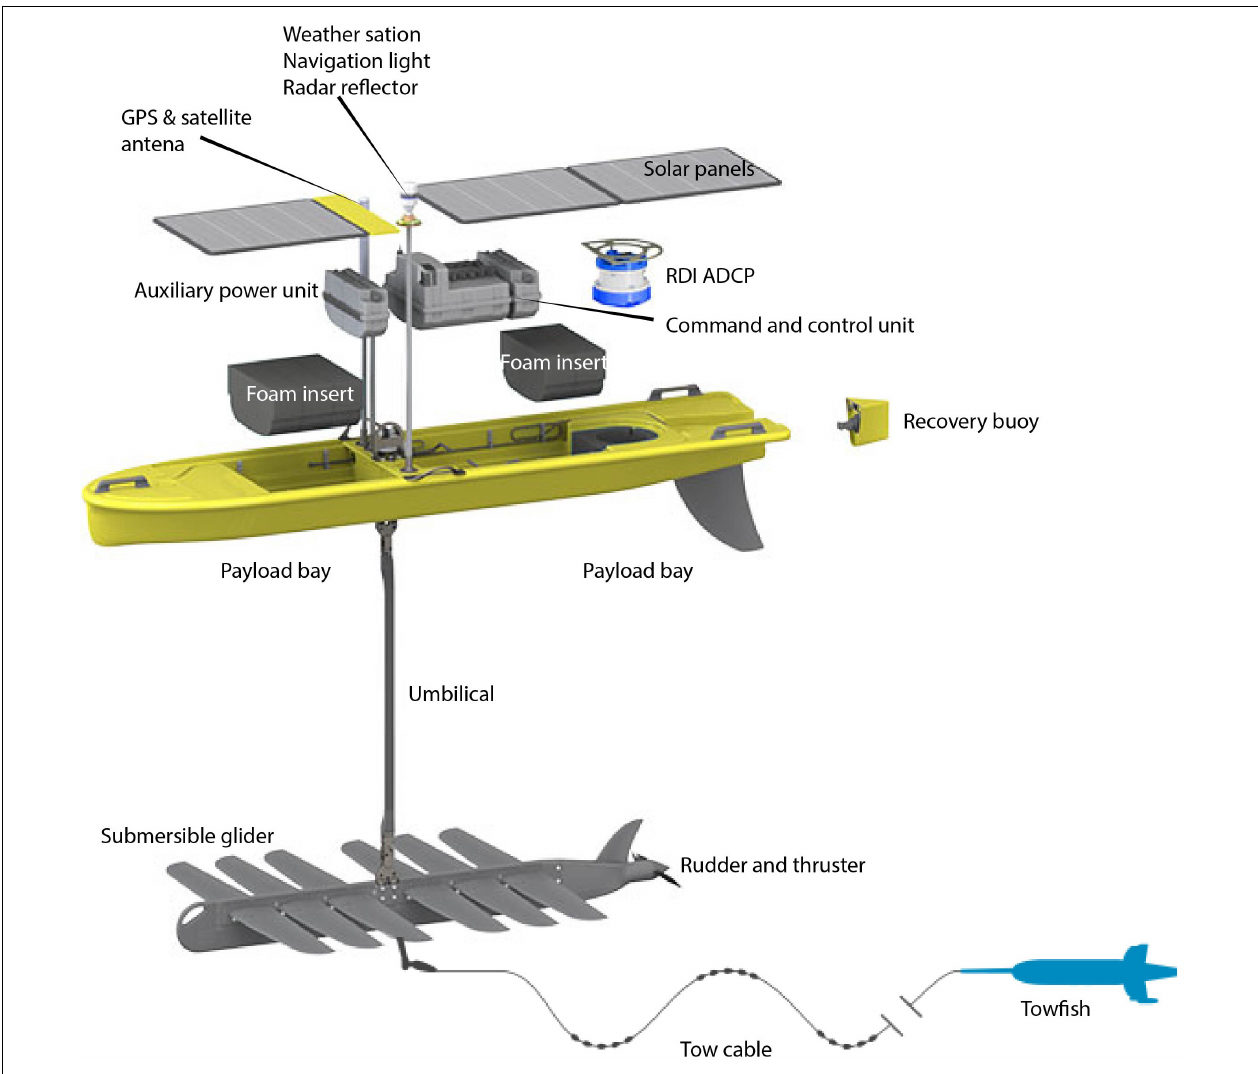
FIGURE 1 | Blow-out showing the components of the Liquid Robotics SV3 wave glider. Image courtesy of Liquid Robotics, Inc., a Boeing